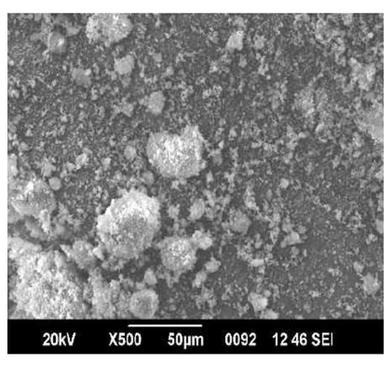
SEM images at (i) resolution of x1500 and (ii) at resolution of 500 for RbCl doped MgO nanomaterial.